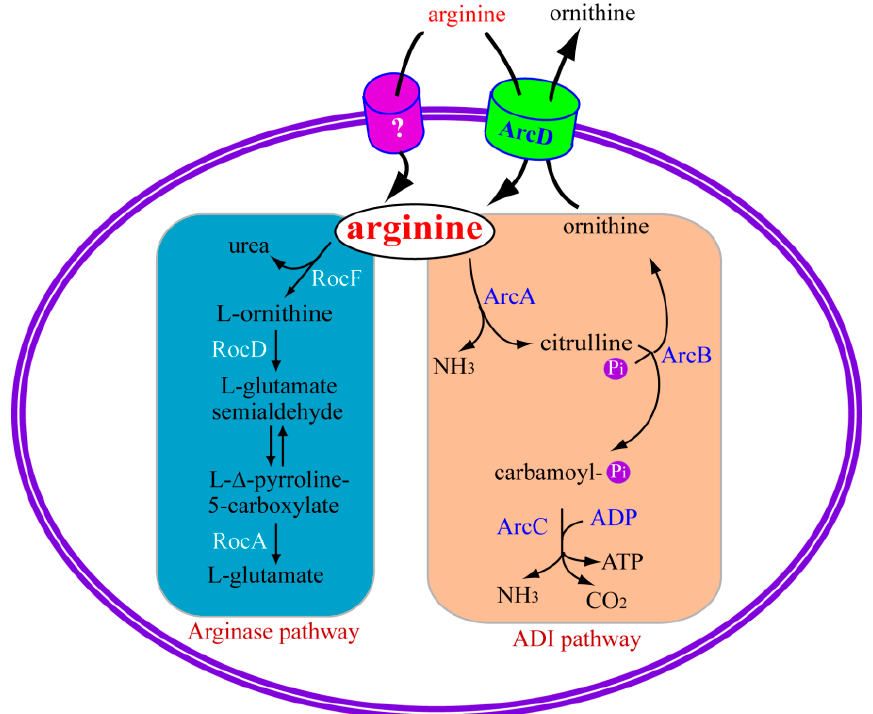
Figure 1. Simplified model for bacterial arginine catabolism by arginase and ADI pathways. In bacteria, arginine could be catalyzed by the arginase pathway (in blue) and/or the ADI pathway (in light salmon). For the arginase pathway, arginine is converted into urea and ornithine, which is subsequently catalyzed into glutamate. The ADI pathway catabolizes arginine to ornithine with the byproducts of ammonia, CO 2 and ATP. The produced ornithine could be transported outside and exchange one molecule of arginine in the cell by the arginine–ornithine antiporter (ArcD) located in the bacterial membrane. Arginine may also be transported by some unknown transporters, which are shown by the question mark. RocD: ornithine aminotransferase; RocF: arginase; RocA: ∆ -pyrroline-5-carboxylate dehydrogenase; ArcC: carbamate kinase; ArcA: arginine deiminase; ArcB: ornithine carbamoyltransferase; Pi: inorganic phosphate. Table 1. The genes from arginase and ADI pathway of bacteria and counterparts in mammalian cells with homologue or similar function.